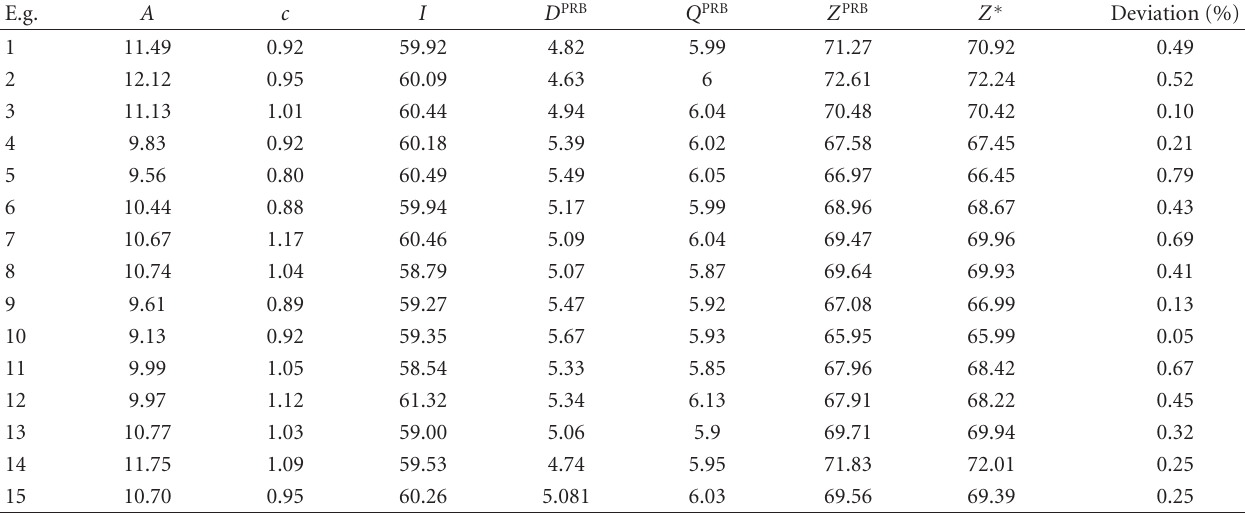
Table 1: Some samples solved using the developed PRBs.